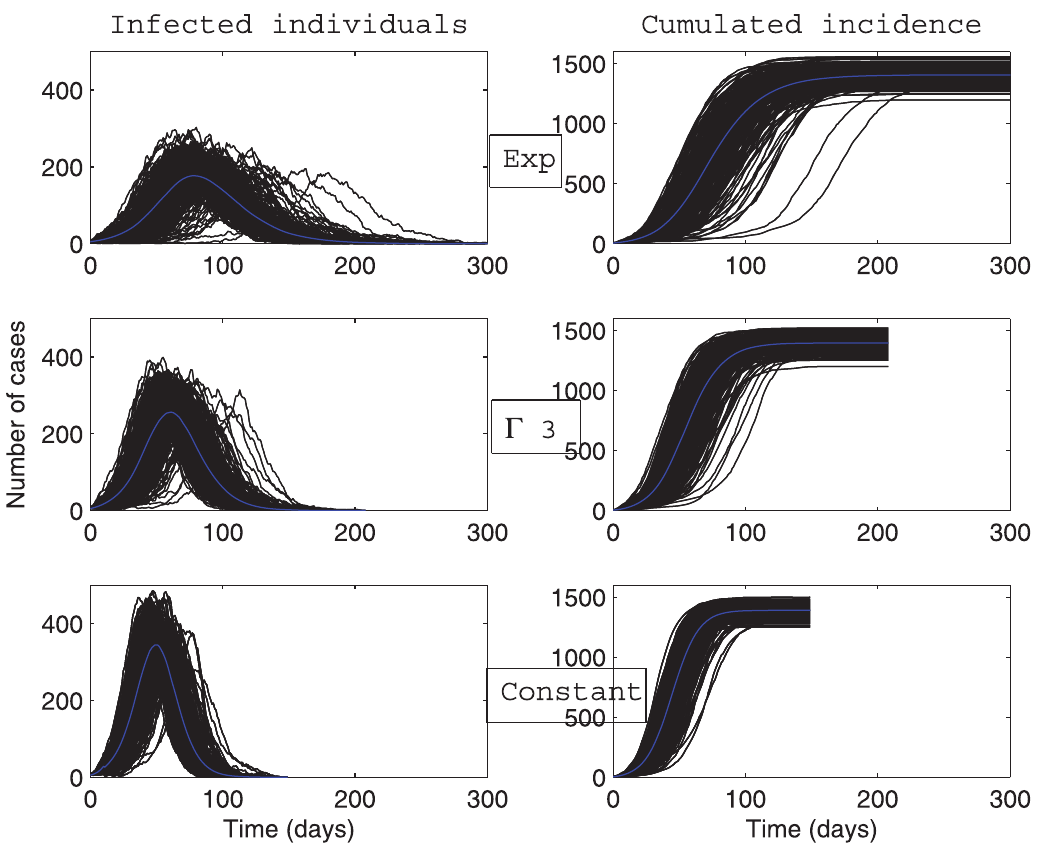
Figure 3. Dynamics of global number of cases and cumulative incidence described by a stochastic metapopulation model based on a completely connected network. Early extinct trajectories were not considered. The mean (blue curve) was calculated over major epidemics only (corresponding to a final attack rate greater than 5 % ). Simulations are performed using a time-continuous event-driven approach with T I * Exp( c ) (top panel), T I * C (3,3 c ) (middle panel) and T I ~ Const ~ 1 = c (bottom panel). Parameters values are given in the subsection Examples of Results.